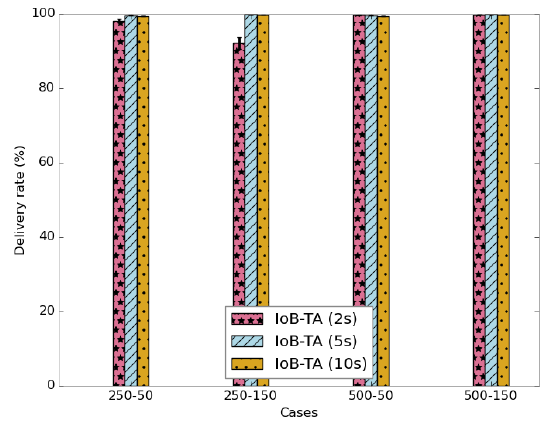
Figure 29. Average delivery rate for